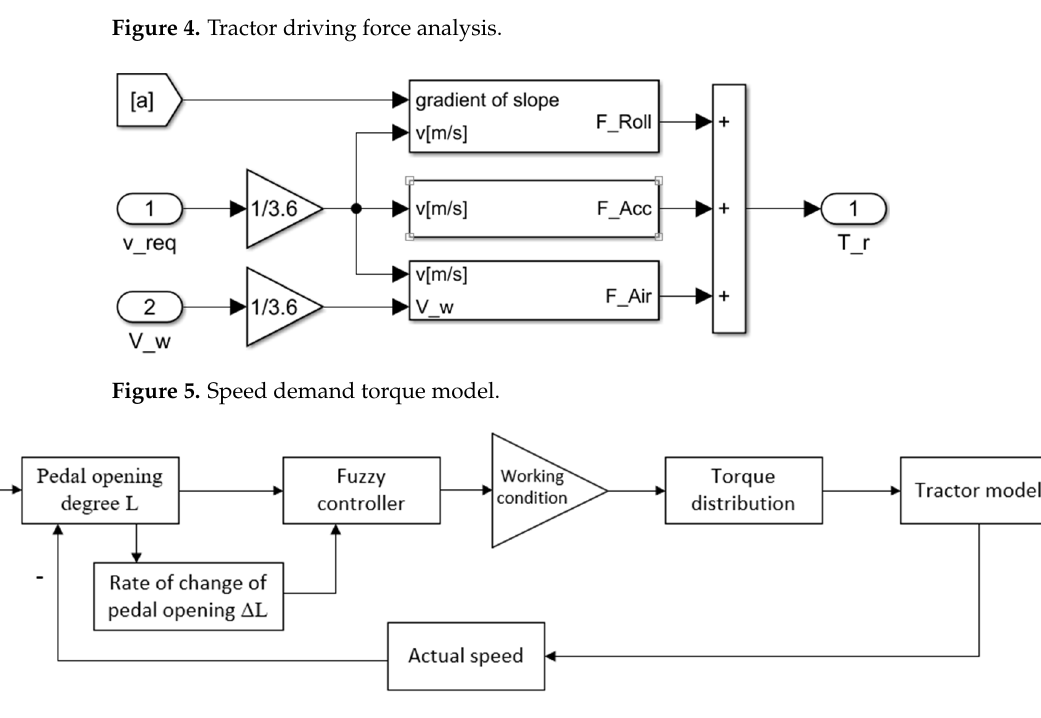
Figure 6. Control model flow chart.